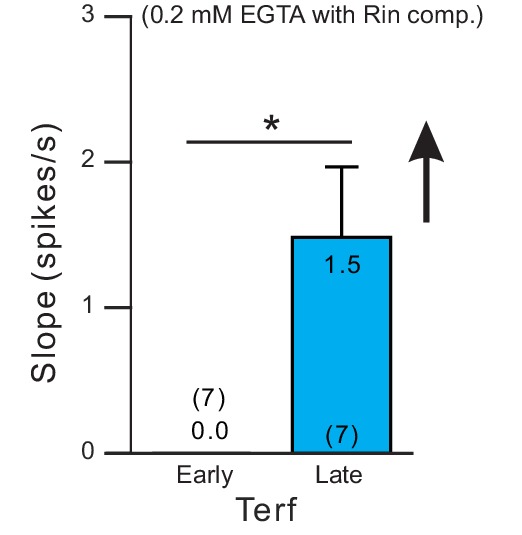
Rate of spike frequency adaptation was increased following ERG blockade with Terf in experiments with weak Ca2+ buffering.Parallel experiment protocol used in Figure 6D but with 0.2 mM EGTA internal solutions (and Rin compensated). *p=0.0296, T = 2.838, paired t-test.